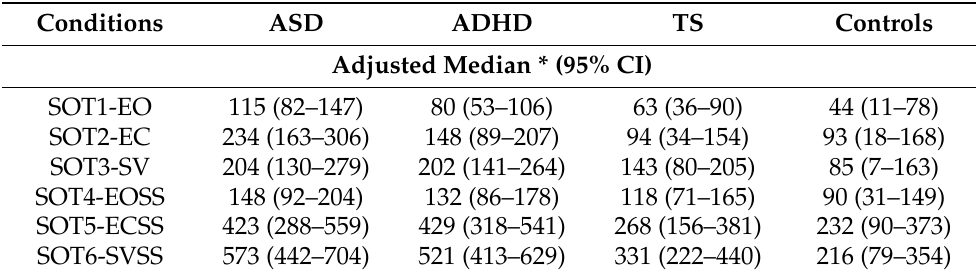
Table 2. Performance in the area parameter among neurodevelopmental disorder (NDD) conditions and controls.